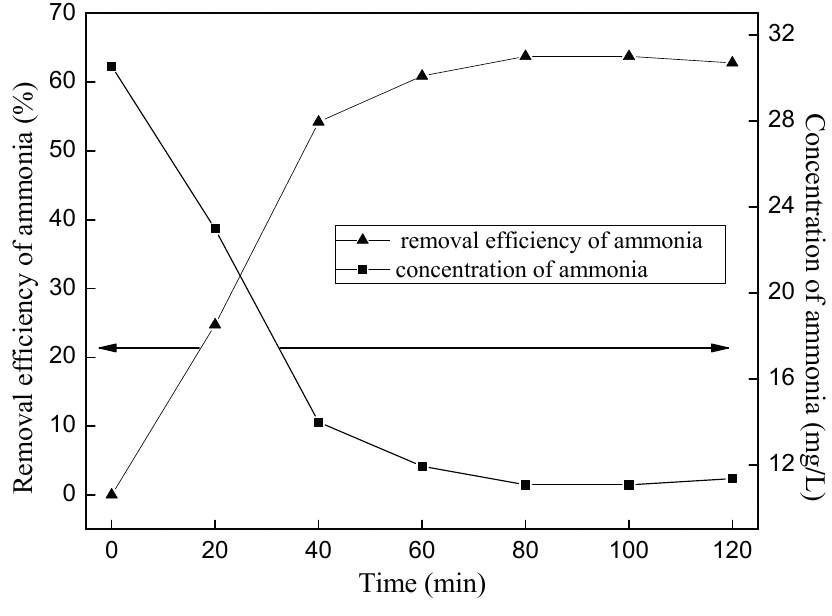
Figure 8. The removal of ammonia by two stages of ozone